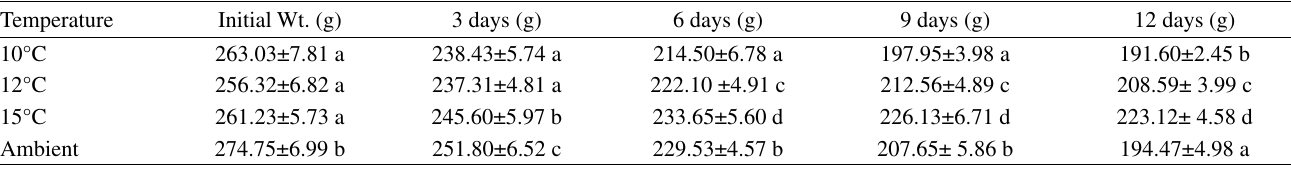
Table 1 - Weights of buriti when stored refrigerated